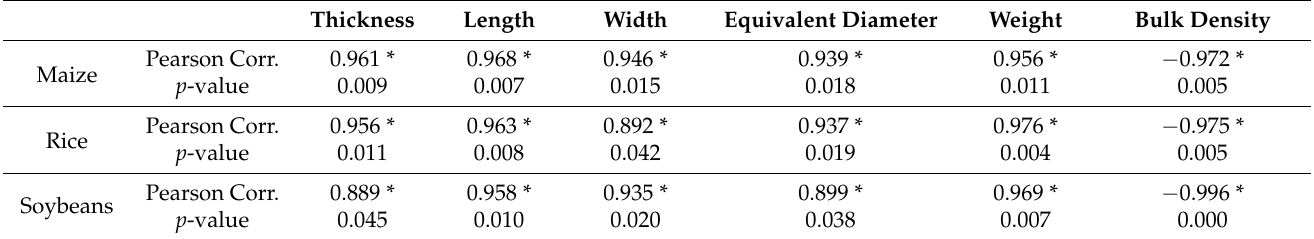
Figure 5. The dependencies between moisture content and bulk density: ( a ) maize, ρ B = − 0.00555 MC + 0.833, R 2 = 0.946, ( b ) rice, ρ B = − 0.00664 MC + 0.905, R 2 = 0.950, ( c ) soybeans, ρ B = − 0.00379 MC + 0.795, R 2 = 0.991; ○ —data, ▲ —mean, ─ —fitted curve, ----—95% confidence band. Table 2. Results of correlation analysis between moisture content and physical properties of grain kernels.